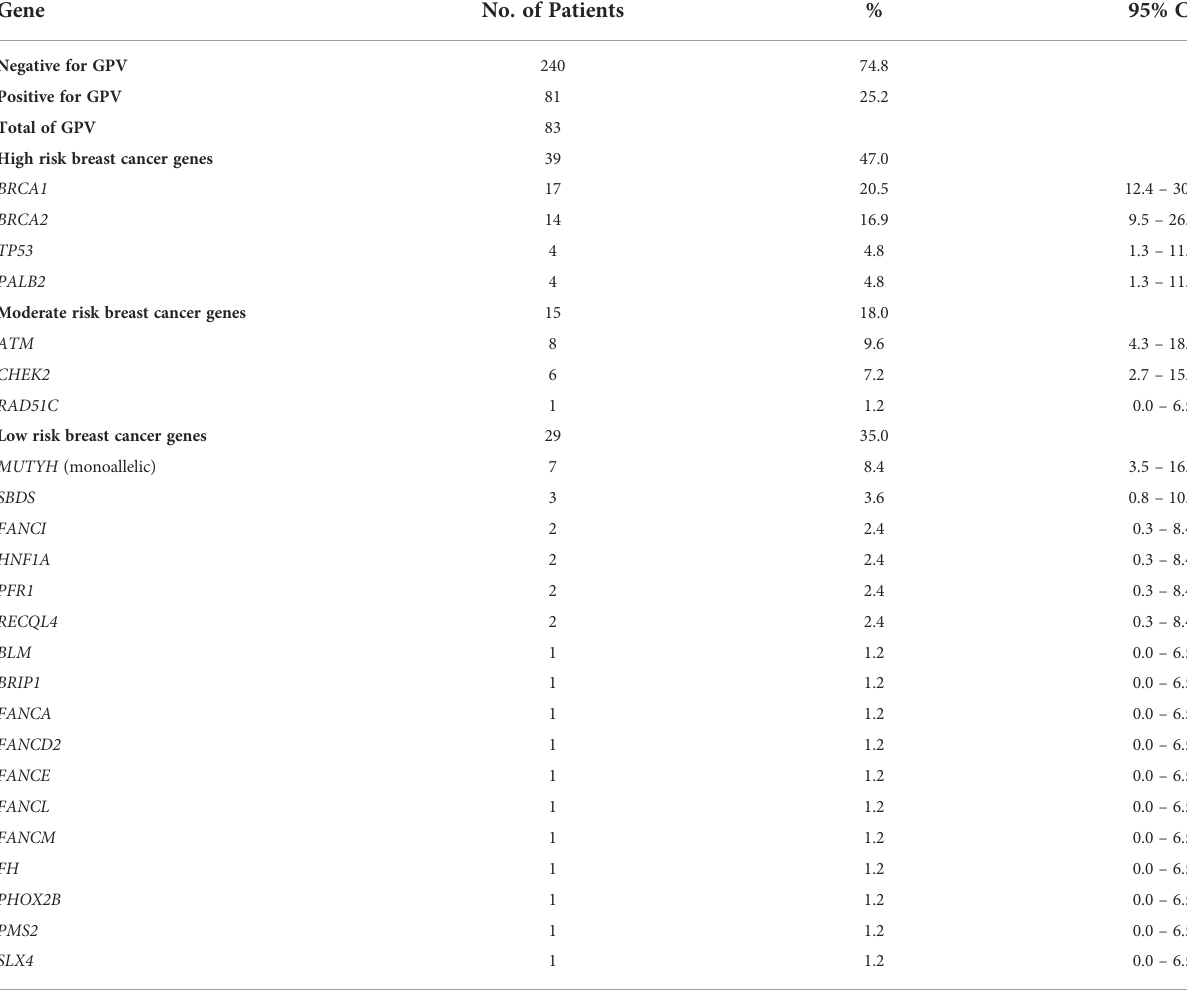
TABLE 2 Frequency of germline pathogenic variants found in the study population.